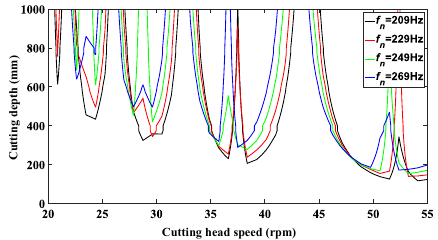
Figure 13. Stability curve of cutting system with different natural frequencies.